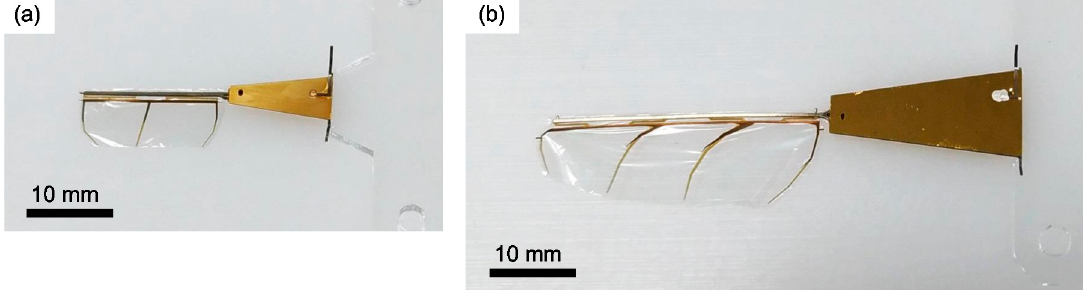
Figure 5. Photograph of prototype actuators: ( a ) small type and ( b ) large type.